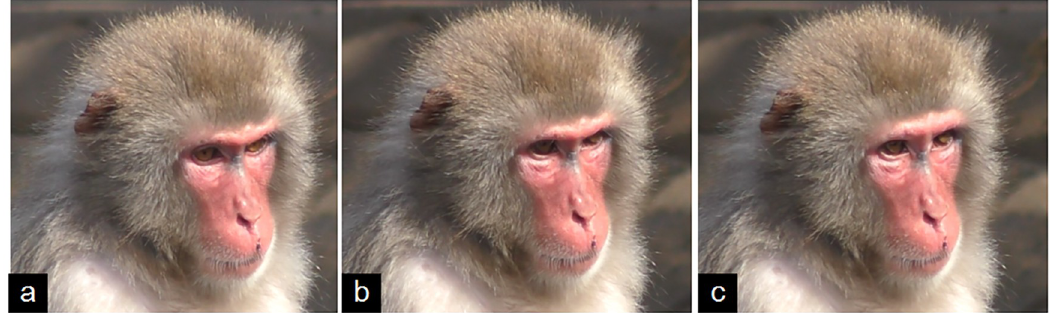
Fig 4. a —Neutral face; b —AD60—Eyes up is acting, with the pupil moved upwards; c —In the next frame, AU1+2—Brow raiser is added to